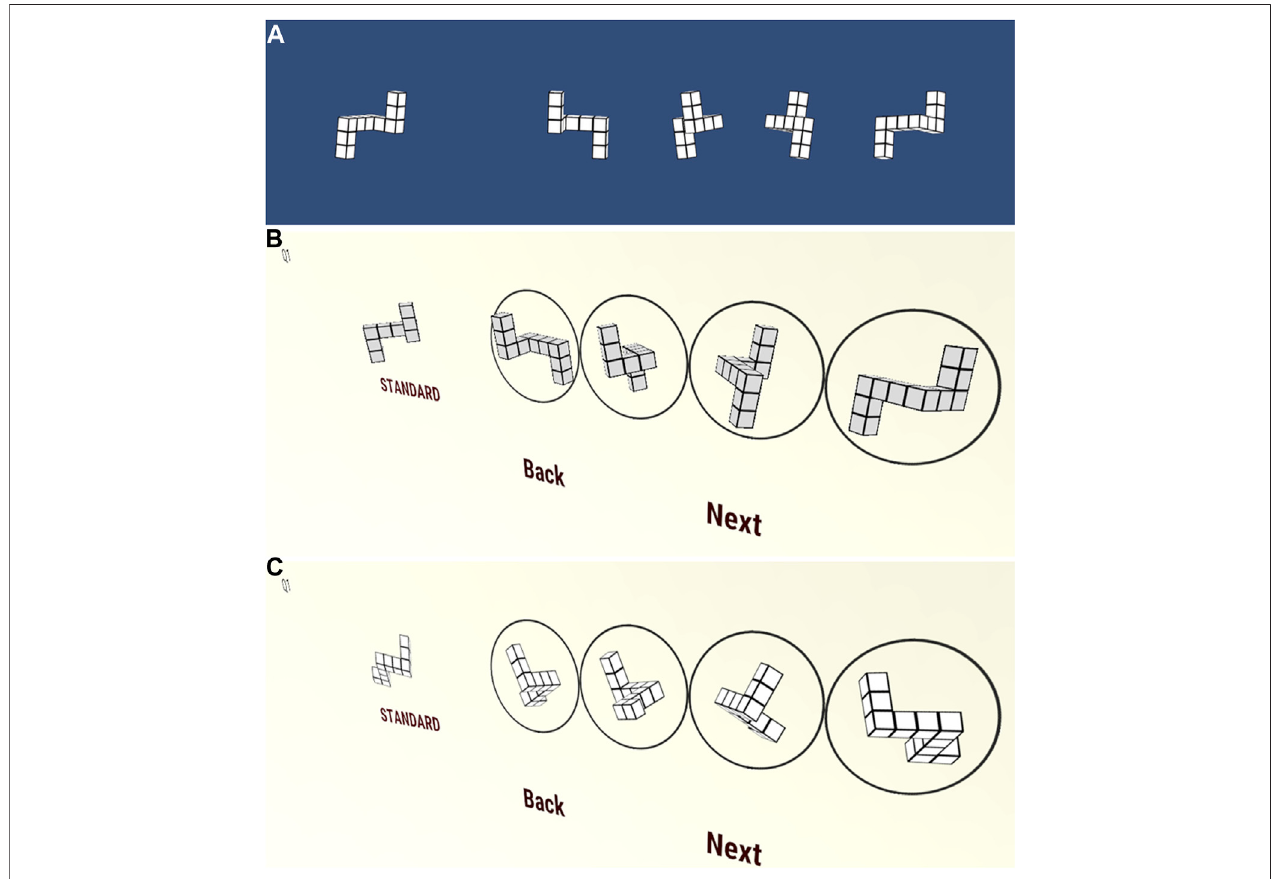
FIGURE 1 | (A) A screenshot from the IMRT question development in Unity. Each question contains a standard stimulus (left) and four reference stimuli (right). These stimuli became the 3D stimuli in Room A (B) and the 2D stimuli in Room B (C) . Perspective view provided here to highlight the difference between the 3D and 2D stimuli (i.e., this is not how the stimuli were shown to participants, they always had the same